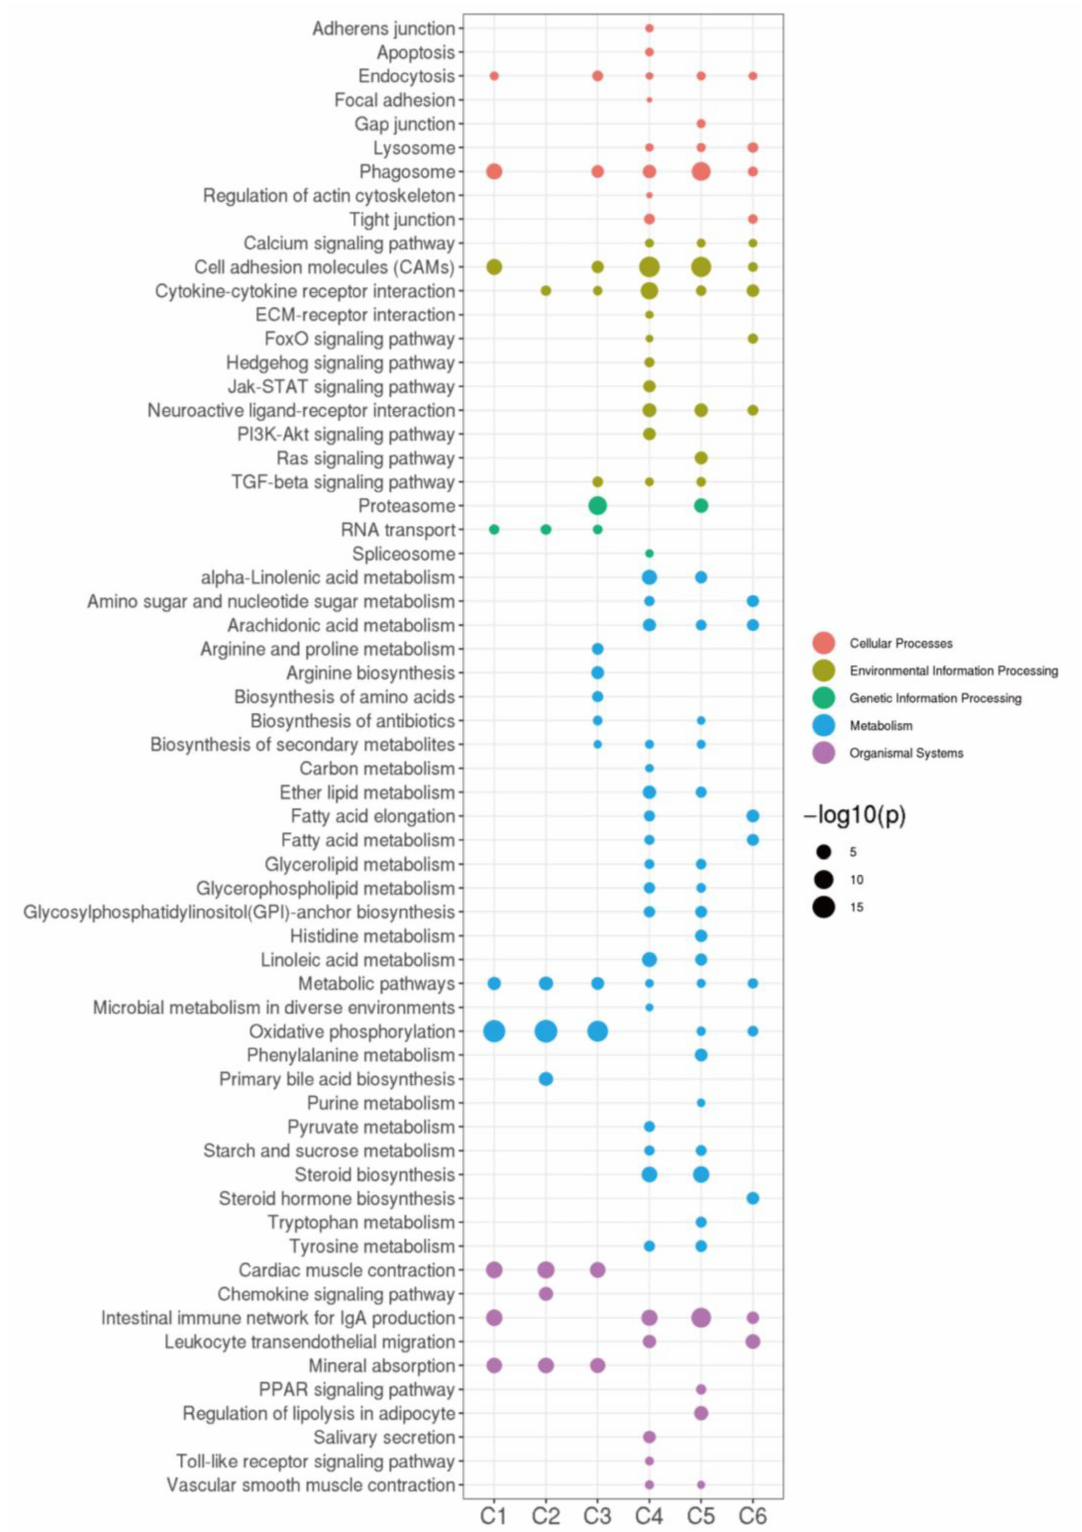
Figure 3. The enriched KEGG pathway annotation for miRNA-mRNA pairs as determined by WGCNA analysis using Q-values. C1, Con-M-VS-MT25-M; C2, Con-M-VS-MT50-M; C3, Con-M-VS- MT100-M; C4, MT25-M-VS-MT50-M; C5, MT25-M-VS-MT100-M; C6,